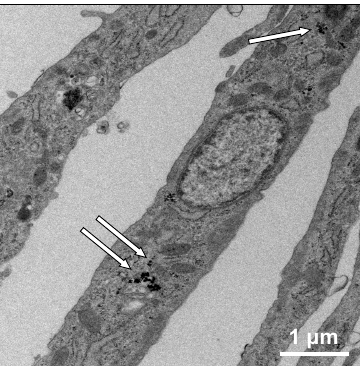
Figure 1. Transmission electron microscopy (TEM) image of odontogenic cells treated with 100 pg-magnetite/cell of magnetic nanoparticles (MNPs) ( × 5000). White arrows indicate intracellular MNPs. Scale bar = 1 μ m.